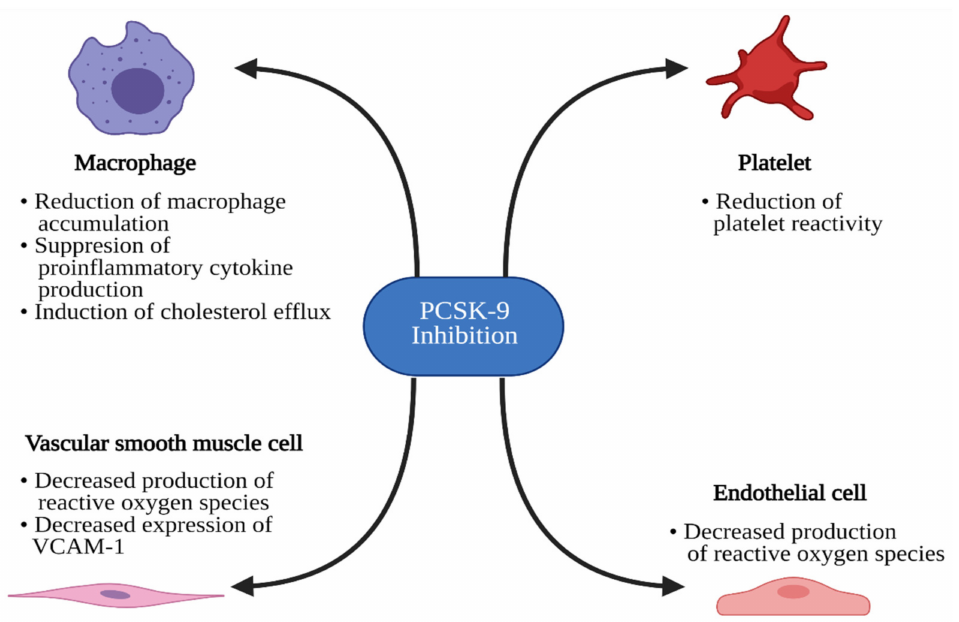
Figure 2. Effects of proprotein convertase subtilisin/kexin type 9 (PCSK9) inhibition on the crucial cells participating in atherosclerosis development. VCAM-1, vascular cell adhesion molecule 1. Figure created with BioRender.com (accessed on 12 May